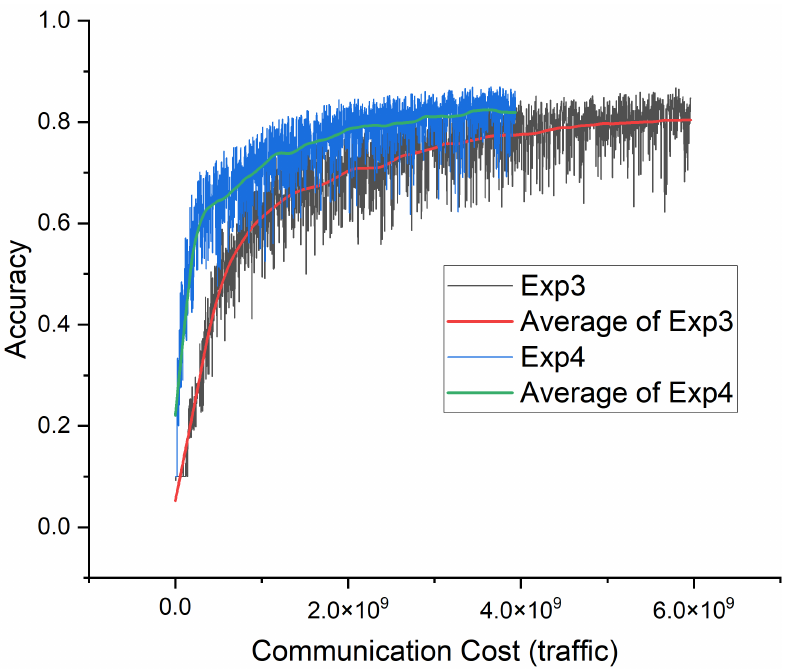
Figure 5. Learning curves of Exp3 and